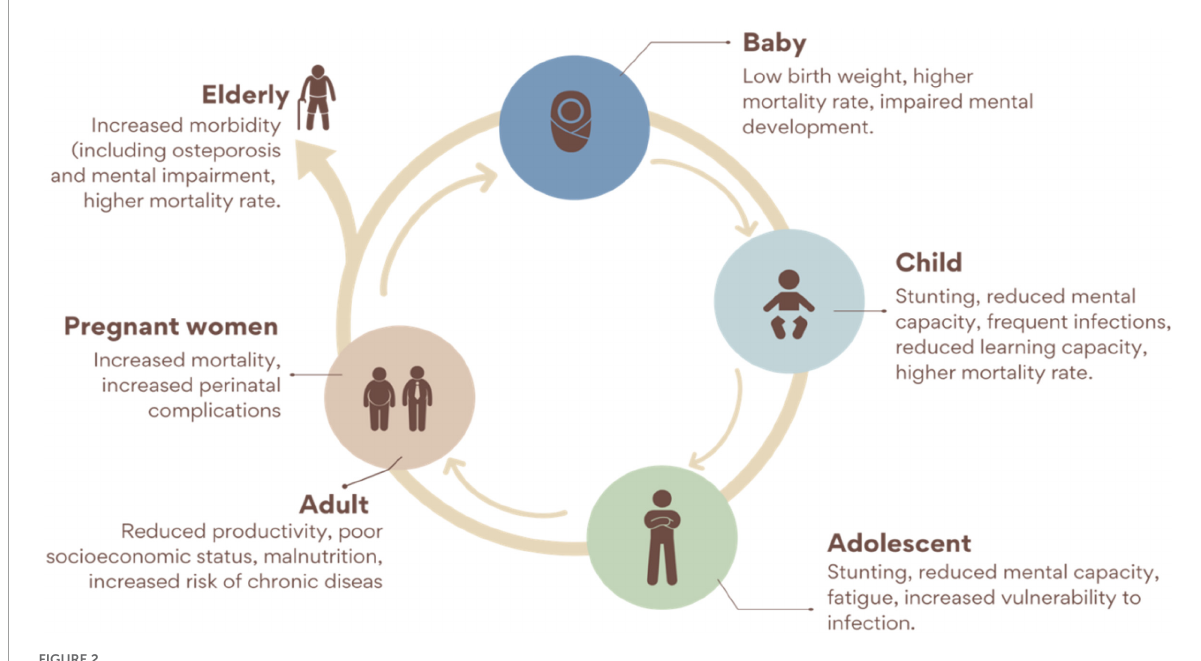
FIGURE2 Consequences of micronutrient deficiency through the life cycle [Modified from (56)].